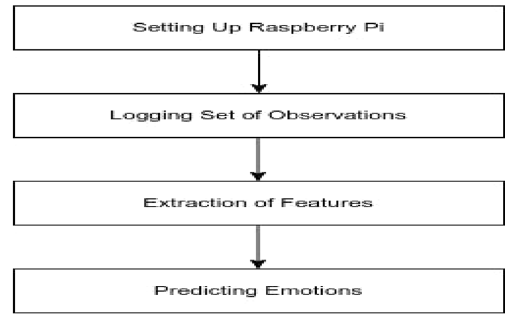
Fig. 3 Flowchart for feature extraction and emotion